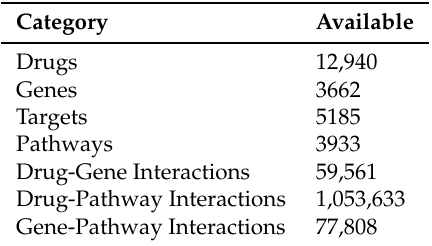
Table 2. DRUGPATH’s statistics.